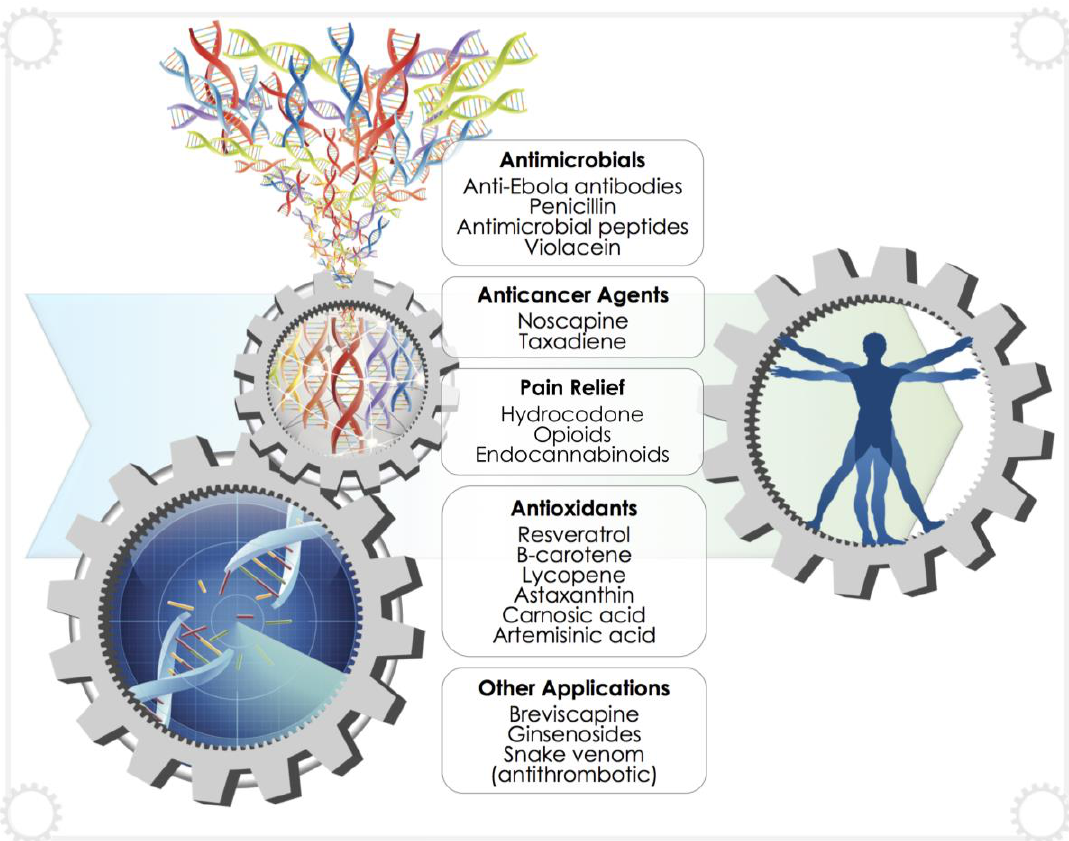
Figure 5. By harnessing the power encoded within genetic material, a wide-range of complex natural products may be produced by yeast cell factories for a diverse range of medical applications. Synthetic DNA is analogous to a computer code that directs the cogs or machinery of yeast cell factories to produce high-value products.